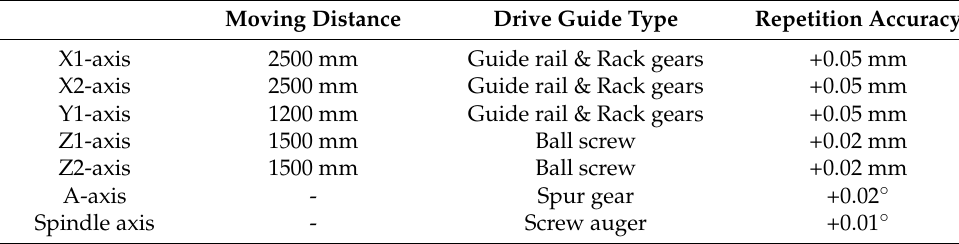
Table 1. Specification of linear and rotation guide.